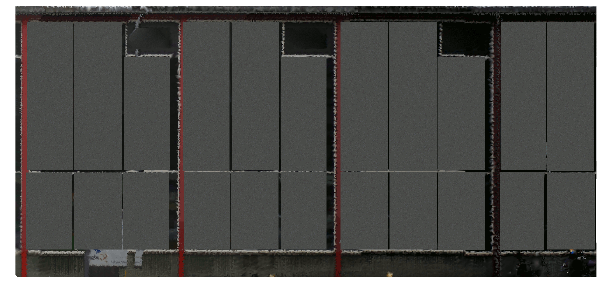
Figure 12: Building facade with filled